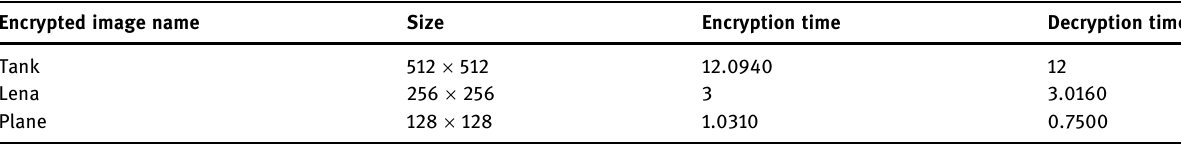
Table 3: Statistics of time spent on encryption and decryption Encrypted image name